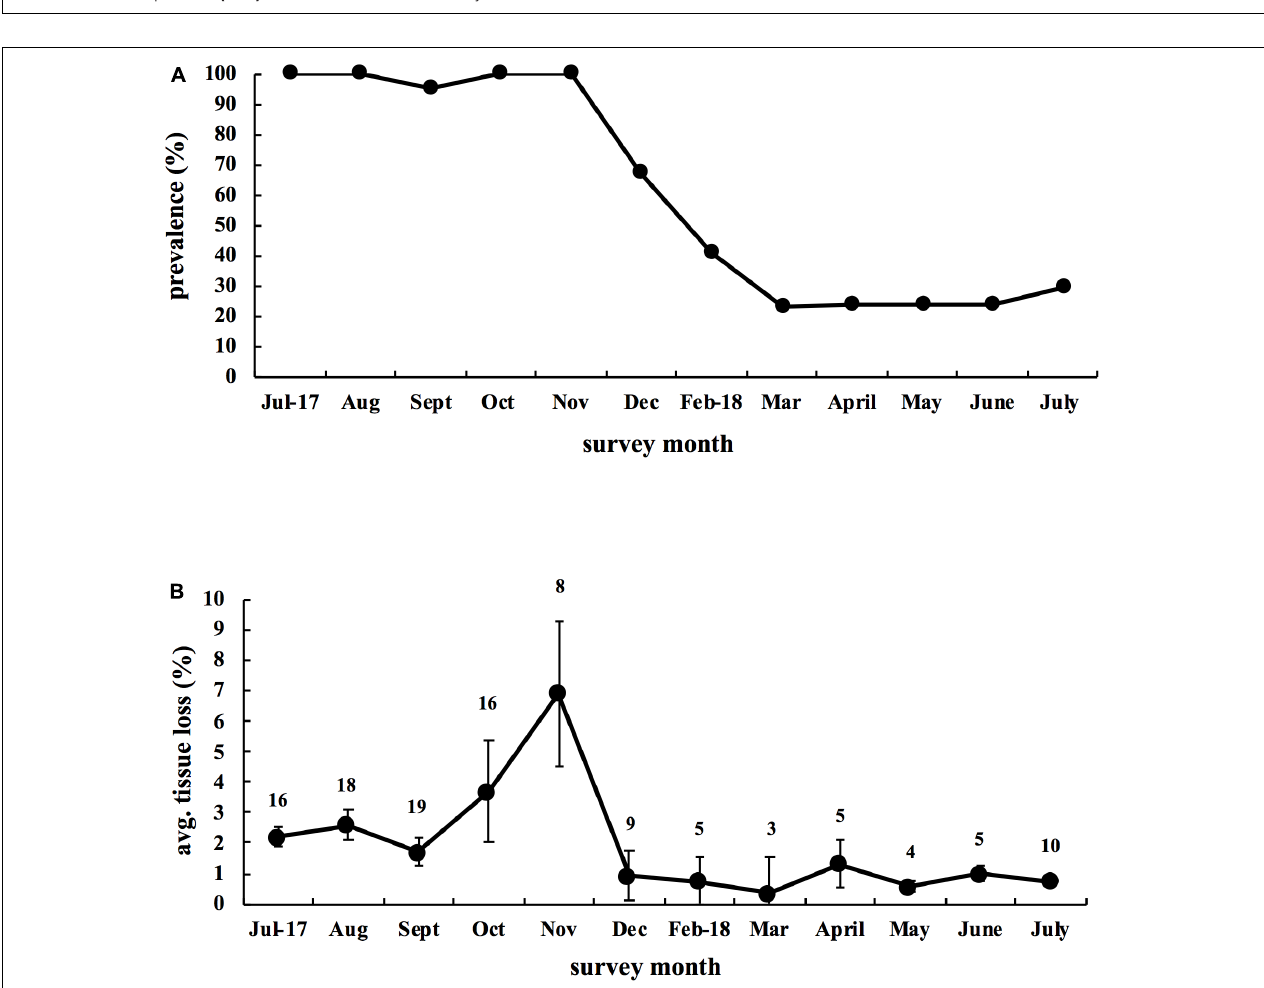
FIGURE 4 | Disease dynamics of 20 infected Montastraea cavernosa colonies tagged in July 2017 and followed for 1 year. (A) Disease prevalence of M. cavernosa colonies through time. (B) Average monthly rate of tissue loss for M. cavernosa through time. Data reflect the mean + SE. Calculation of monthly tissue loss was based upon colonies having active lesions the month prior. Number above each month indicates the number of active colonies used for each month’s calculation.